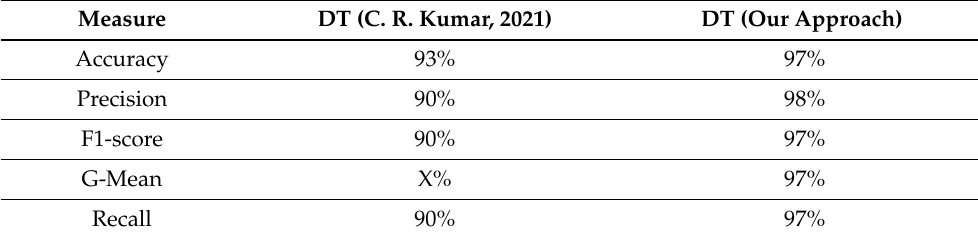
Figure 9. Score values of the various measures for groups. Table 5. Comparison with similar work for the different measures (Udacity